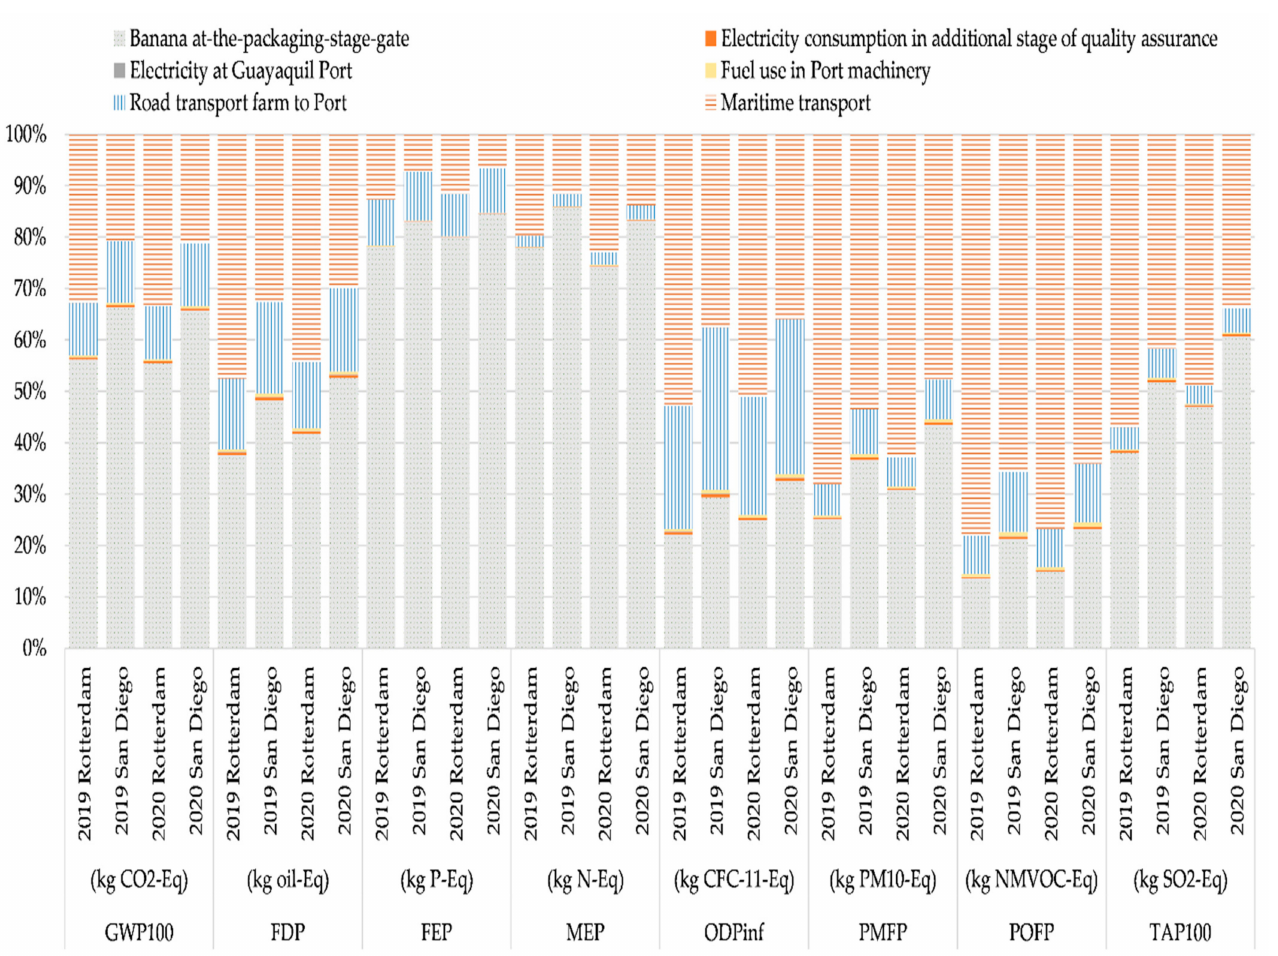
Figure 4. Contribution analysis for each of the processes involved in “Banana at-the-foreign-port” for years 2019 and